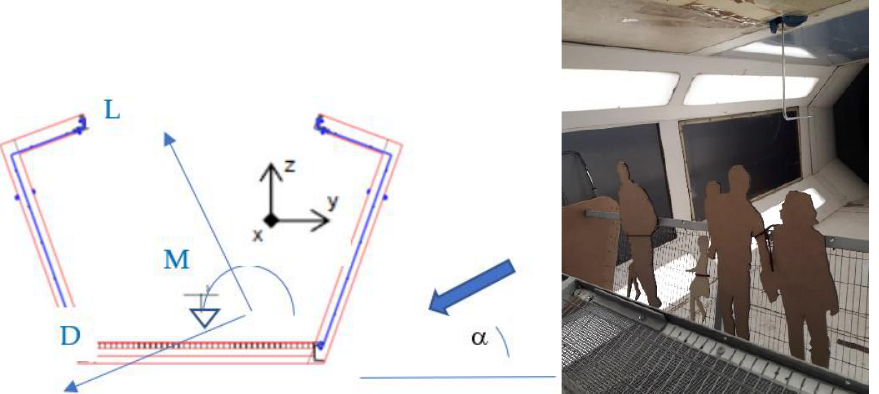
Figure 6. Aerodynamic angle of attack, forces (L, D), e moment (M), and silhouettes of bridge users.